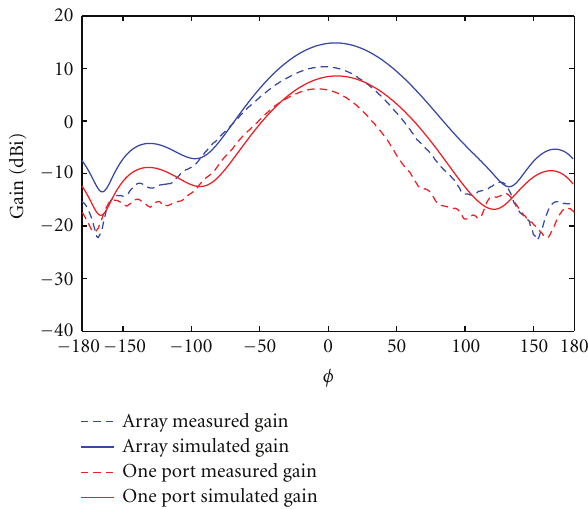
Figure 12: Array on Azzurri: gain pattern at 2.45 GHz, in the azimuth plane ( yz -plane), simulation versus measurement of the entire array and of one single